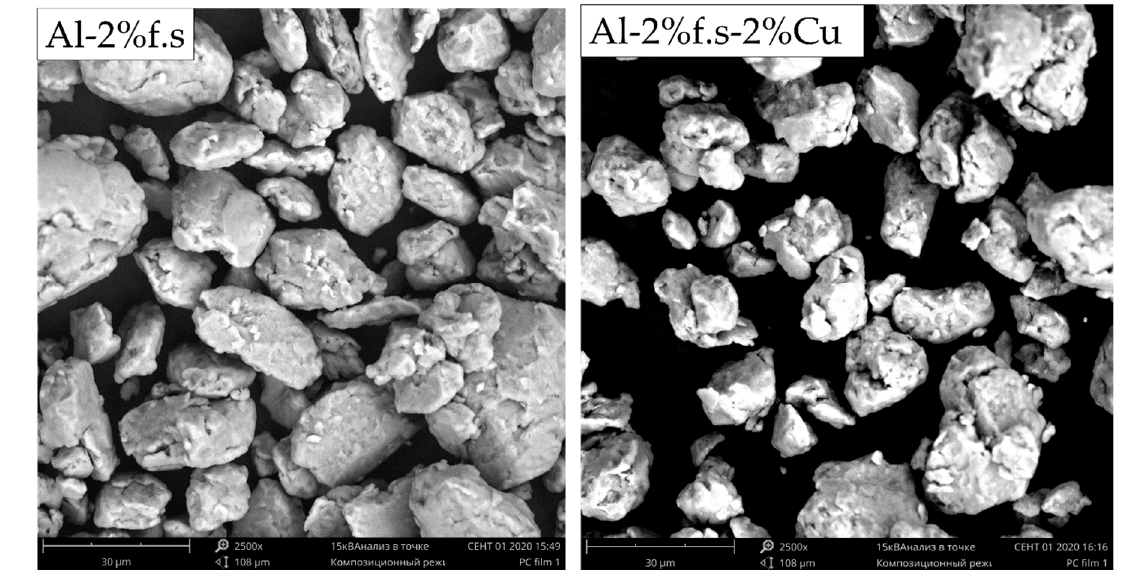
Figure 2. SEM images of the composite powders.